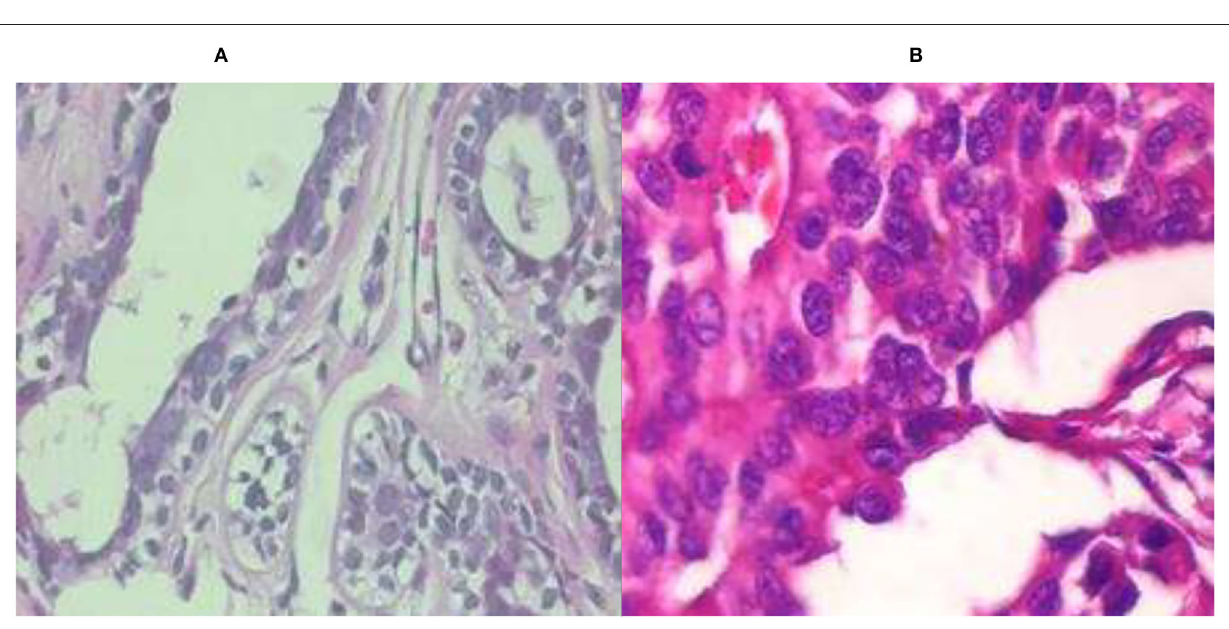
FIGURE 2 | Histopathology image samples: (A) benign and (B)